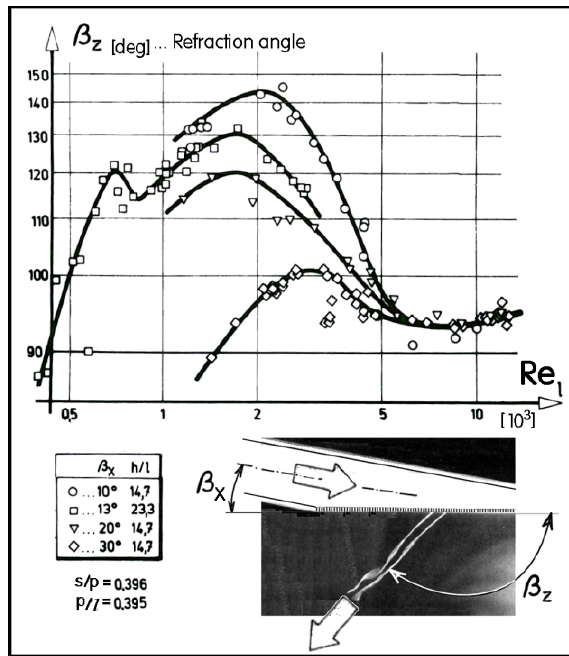
Fig. 19. Typical photograph of small detail of visualised blade cascade in water seeded by aluminium dust particles. Most important role play the stationary vortices, indicated in Fig. 20.